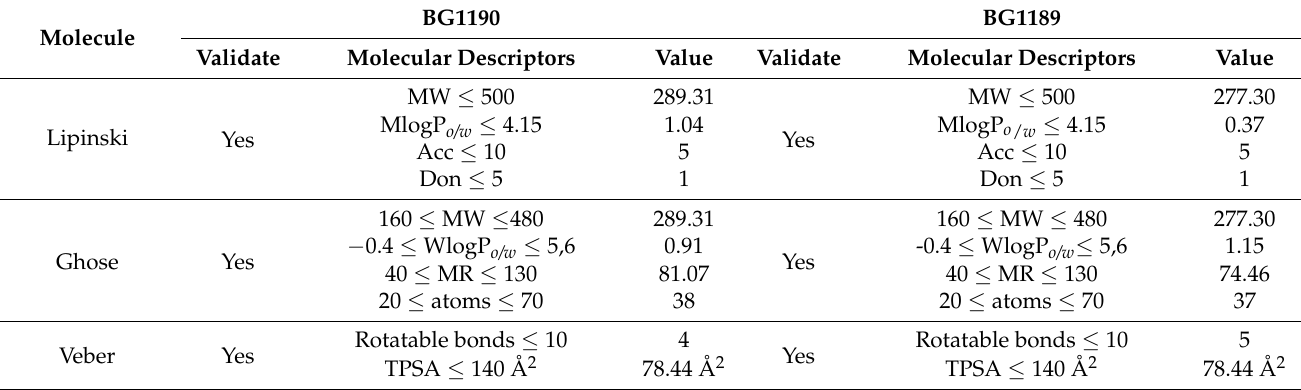
Table 1. Drug-like rules Lipinski, Ghose and Veber validation for molecules BG1189 and BG1190.